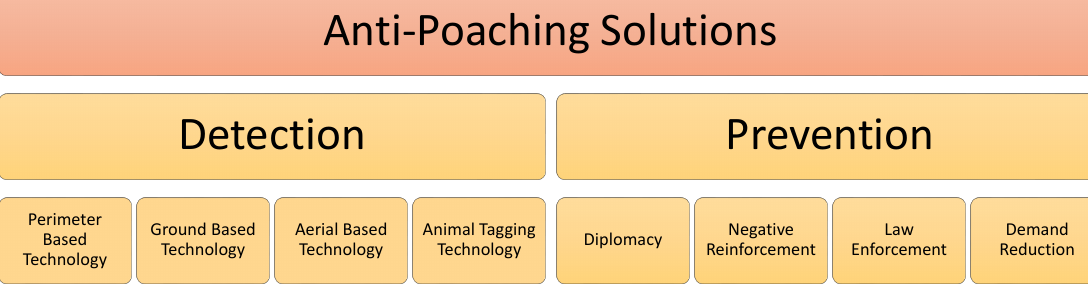
Figure 3. Anti-poaching